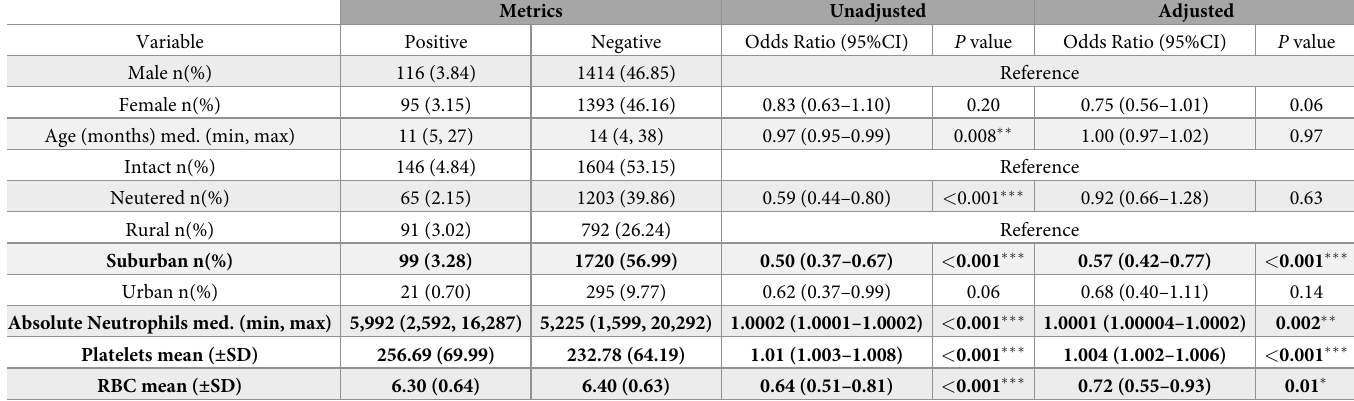
Table 1. Adjusted and unadjusted odds ratios and confidence intervals for the complete blood cell count model. Bolded parameters were significant in the adjusted model. Metrics